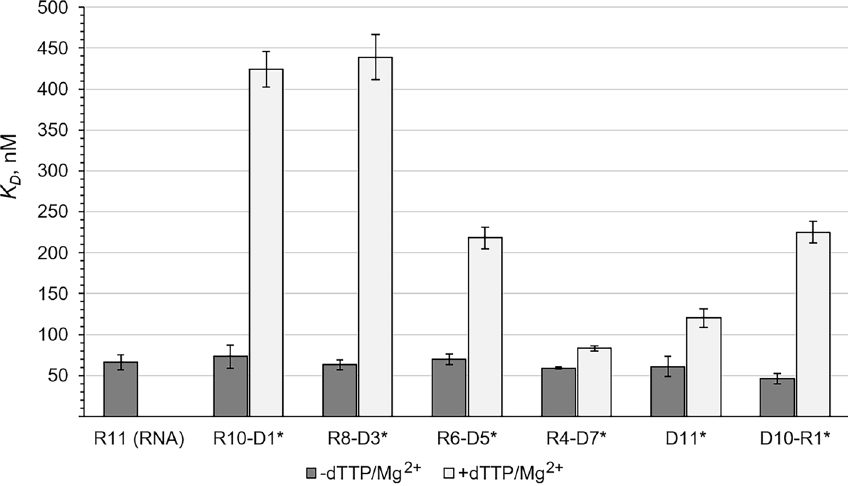
Figure 2. Effect of primer structure and dTTP/Mg 2+ on hPolε CD affinity to a template:primer. The K D values from Table 2 are presented as bar graphs showing the mean ± SD (n = 3). The primer type is indicated below the bar. Asterisk indicates the absence of primer 3 ′ -hydroxyl.